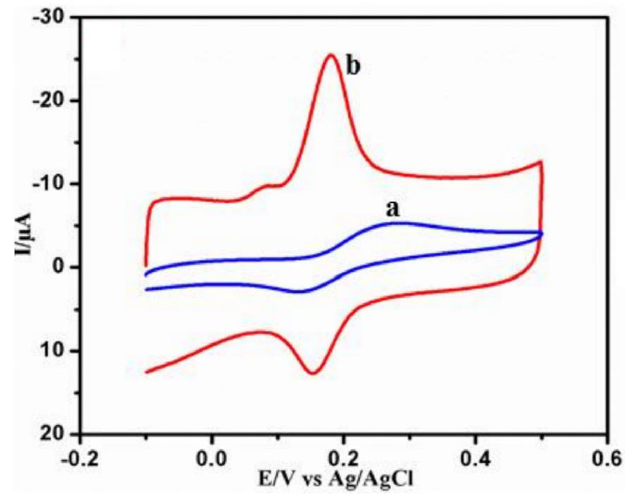
Figure 5. Cyclic voltammetry of bare SPCE (a) and f − MWCNT/SPCE (b) in the presence of 500 µ mol Figure 5. C yclic voltammetry of bare SPCE (a) and f−MWCNT/SPCE (b) in the presence of 500 μmol L −1 CT in 0.05 mol L −1 PB solution (pH 7.0) at a scan rate of 50 mV s −1 . Reprinted with permission L − 1 CT in 0.05 mol L − 1 PB solution (pH 7.0) at a scan rate of 50 mV s − 1 . Reprinted with permission from ESG from Ref. [113]. from ESG from Ref.